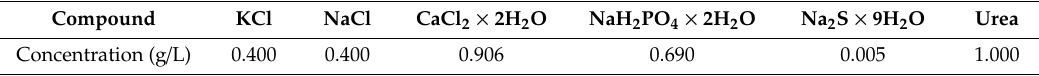
Table 1. Chemical composition of Fusayama-Meyer’s artificial saliva, pH 5.3.